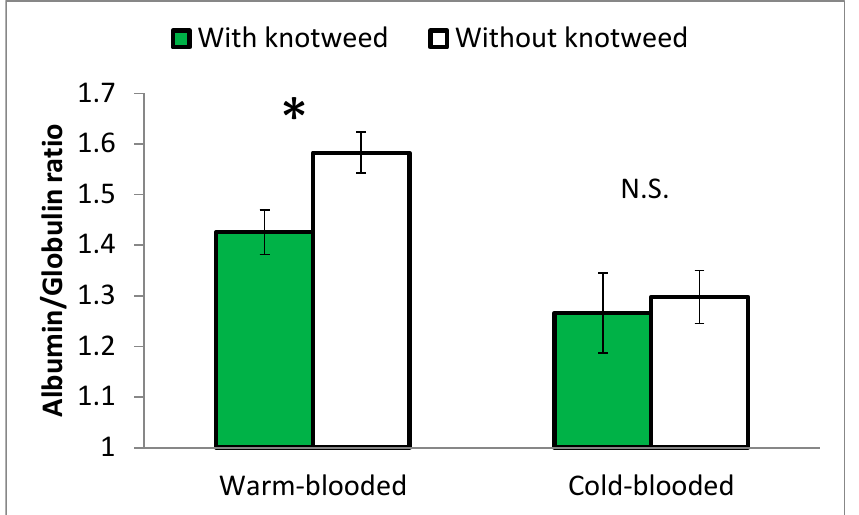
Figure 4. Albumin/globulin ratio in the blood of warm-blooded and cold-blooded stallions fed with and without knotweed, Experiment 1. Means ± SEM. Statistically different values at p ≤ 0.05 are marked with *; N.S. = non-significant difference.